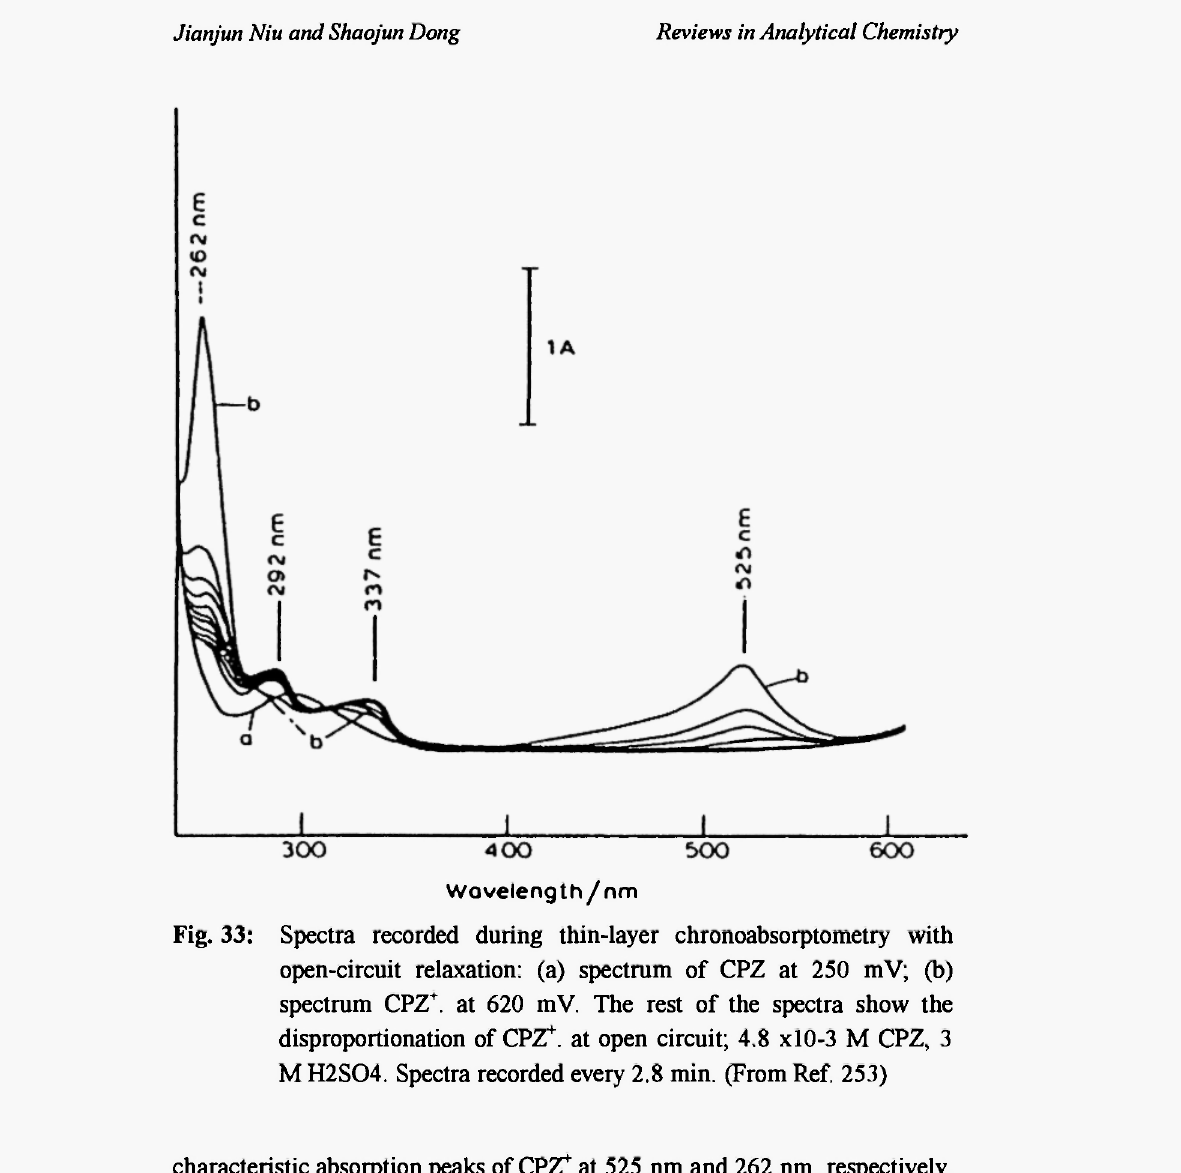
characteristic absorption peaks of CPZ" at 525 nm and 262 nm, respectively. This indicates that CPZ is quantitatively converted into CPZ + . The TLC is then open-circuited to monitor the absorption spectra changes. The subsequent chemical reaction of CPZ + is observed and the final product is CPZO as evidenced by the decrease of the absorption peak 525 nm and 262 nm for CPZ" and the increase of the characteristic absorption peaks of CPZO at 292 nm and 337 nm. The 1/C or 1 /A ~ t curves for the